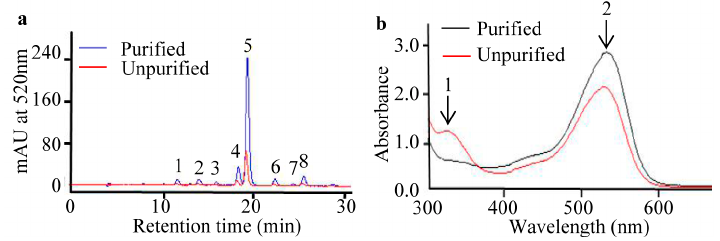
Figure 2. Different characteristics of purified and unpurified anthocyanin extracts from S. nigrum fruits. ( a ) HPLC chromatograms of purified and unpurified anthocyanins from S. nigrum fruits; ( b ) Spectral characters of purified and unpurified anthocyanins from S. nigrum fruits. 1: absorption peak of hydroxycinnamate; 2: absorption peak of anthocyanins.